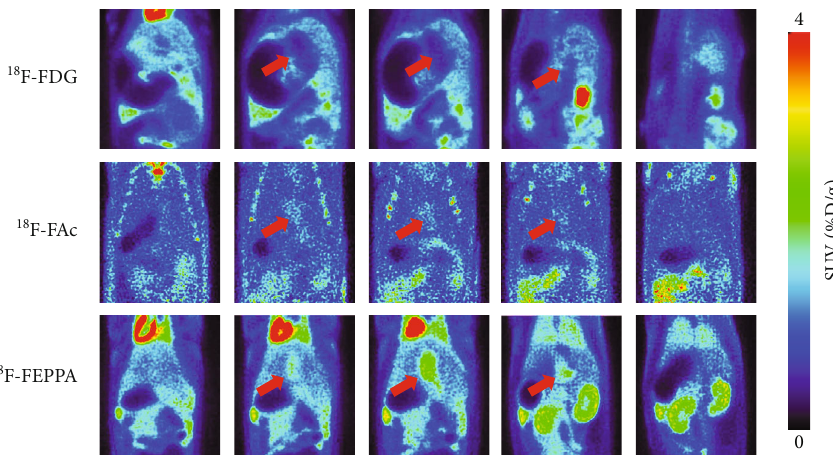
Figure 5: Positron emission tomography images at di ff erent slice locations 2 weeks after bile duct ligation. The red arrows indicate the dilated bile ducts.